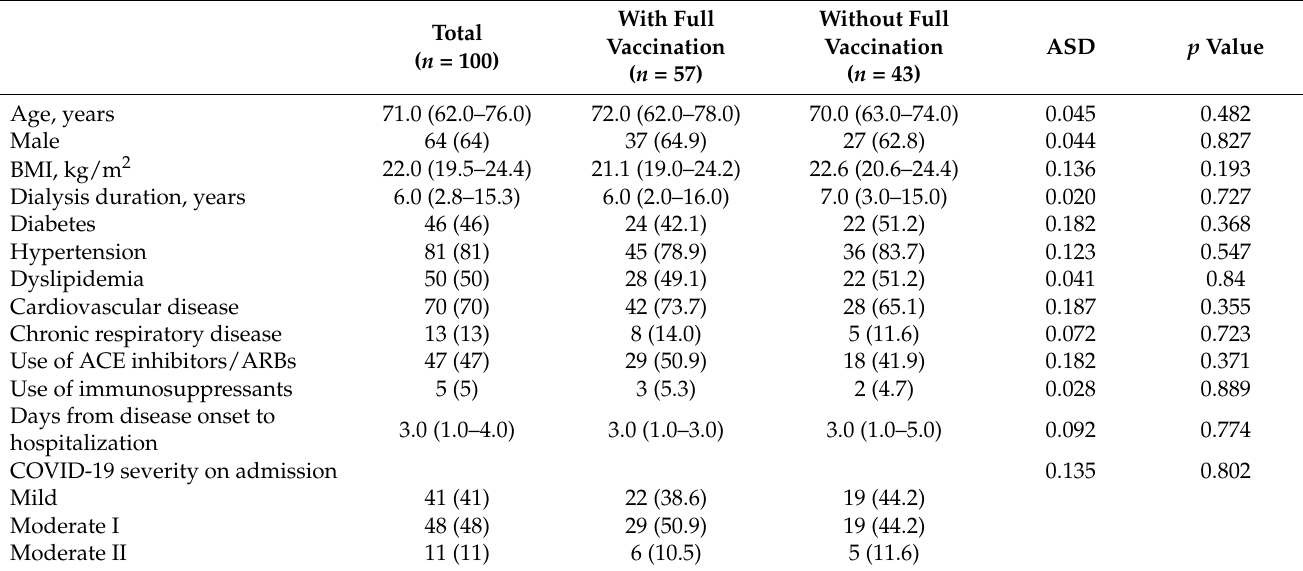
Table 1. Clinical characteristics of dialysis patients with non-severe COVID-19 ( n = 100), and compar- isons between those with and without full